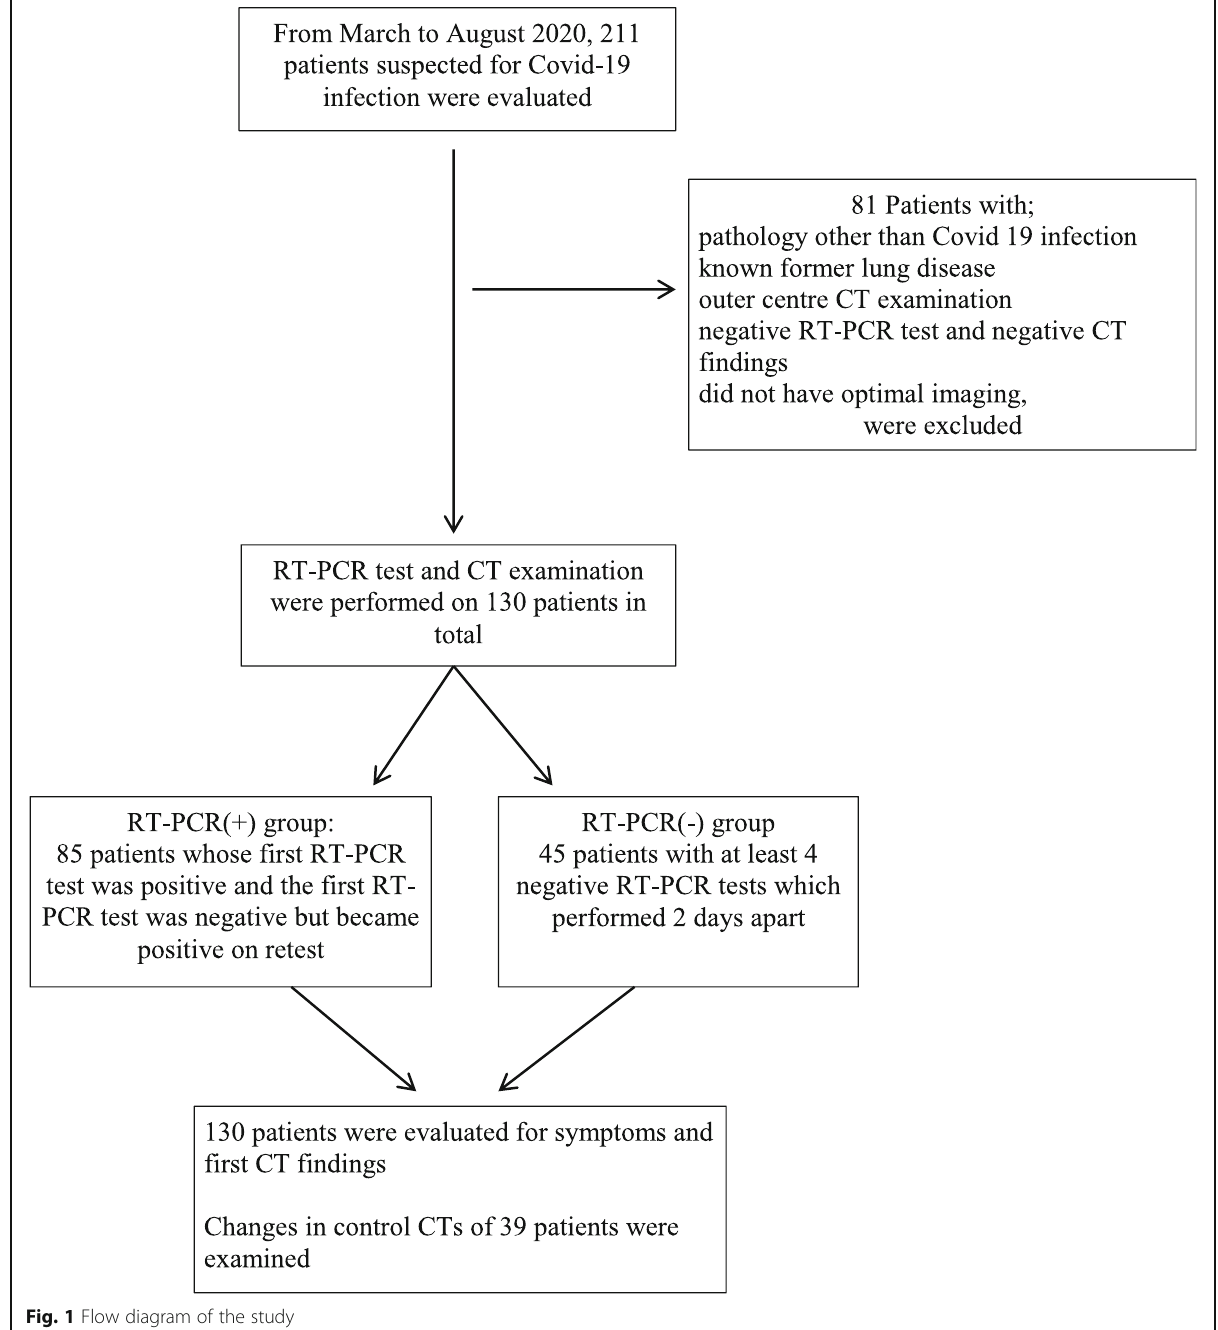
Fig. 1 Flow diagram of the